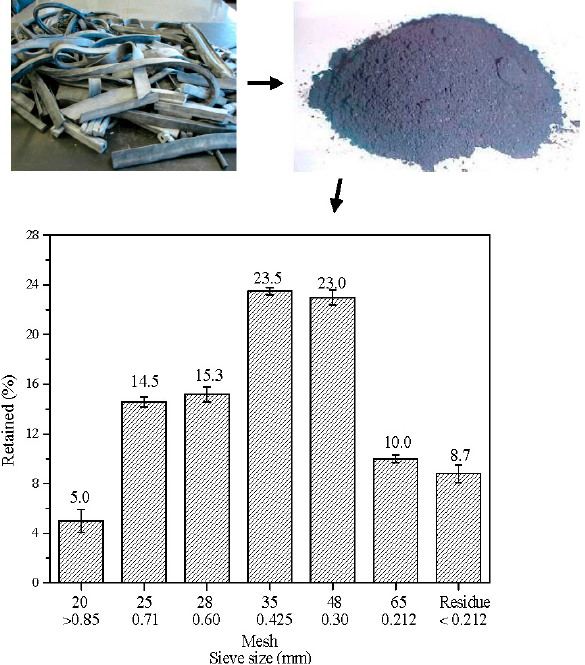
Figure 1. Particle size distribution of ethylene-propylene diene monomer rubber residue (EPDM-r).